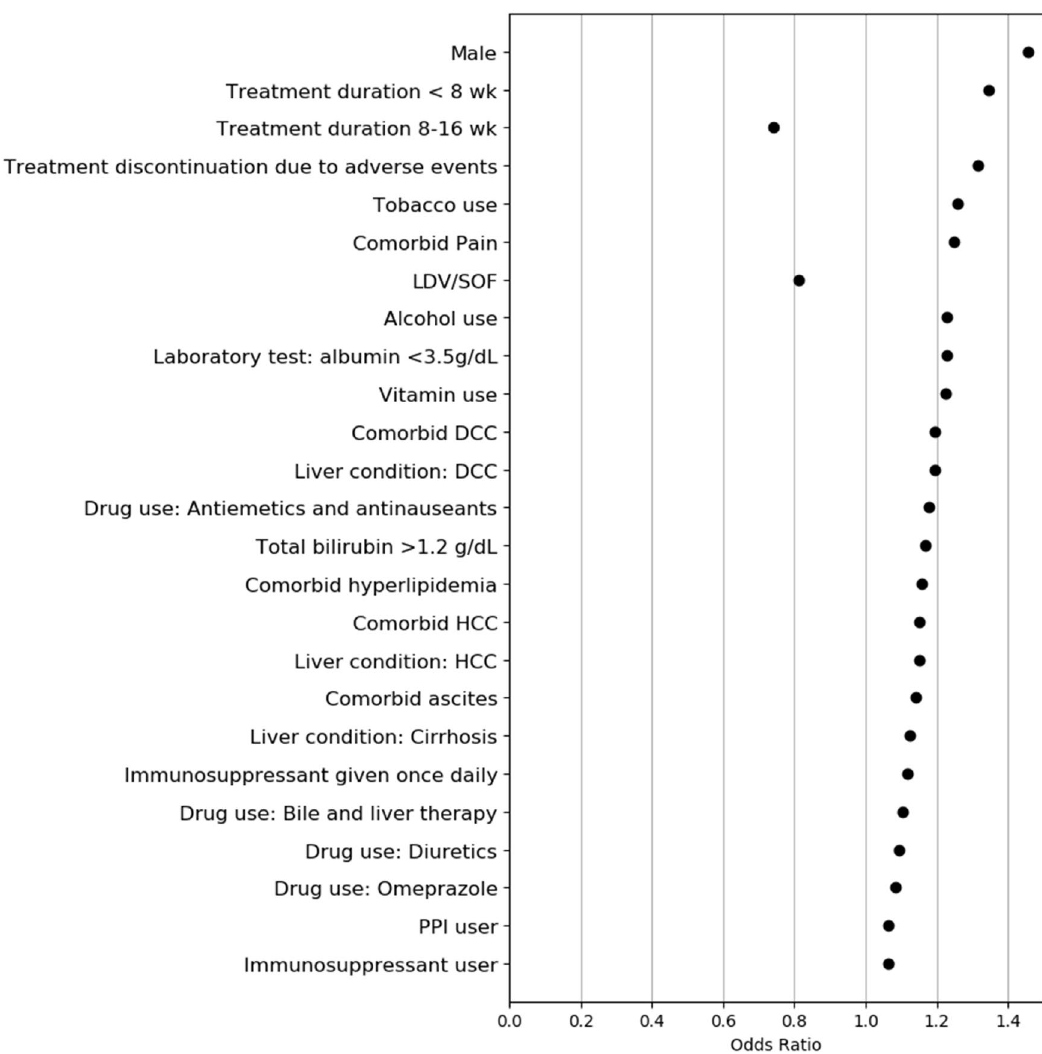
Figure 3. Elastic net model identification of 25 key prediction factors associated with direct-acting antiviral treatment failure a . DCC decompensated cirrhosis, HCC hepatocellular carcinoma, LDV/SOF ledipasvir/ sofosbuvir, PPI proton pump inhibitor. a Predictors are ordered by factor importance based on odds ratios. Elastic net regularization does not provide an estimate of precision; therefore, 95% CIs are not